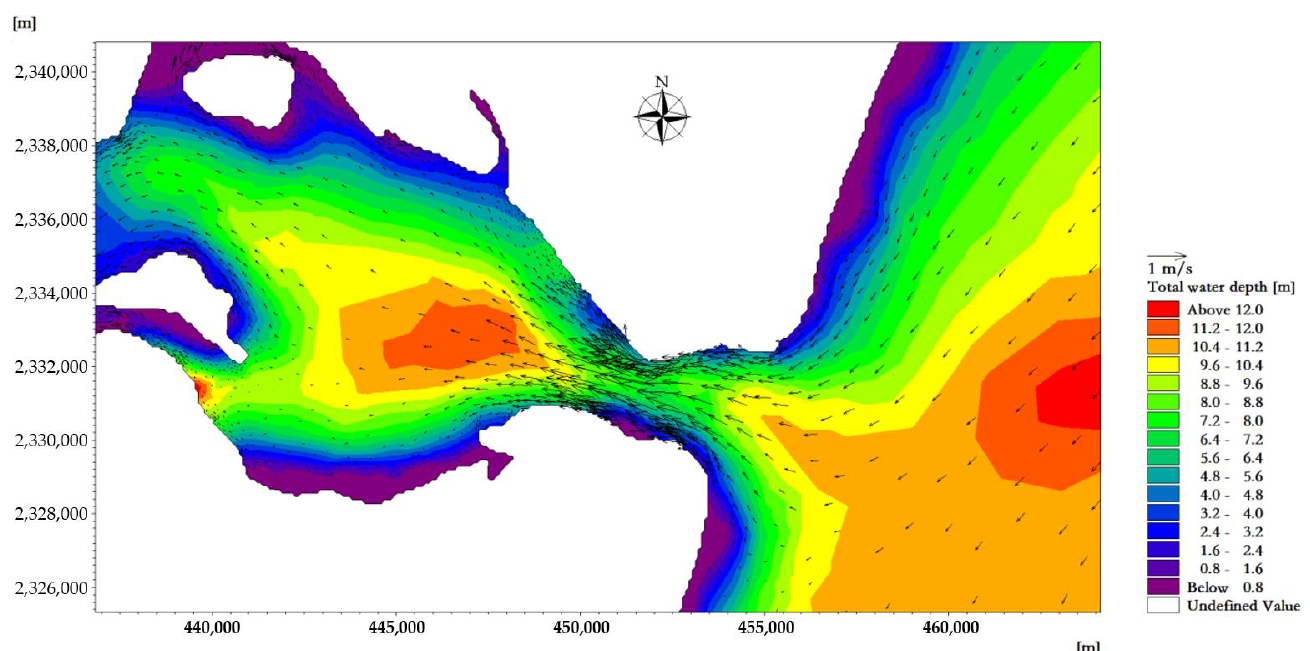
Figure 7. Flow field plane distribution near the tidal inlet at the moment when the velocity of the flood tide reaches its maximum.